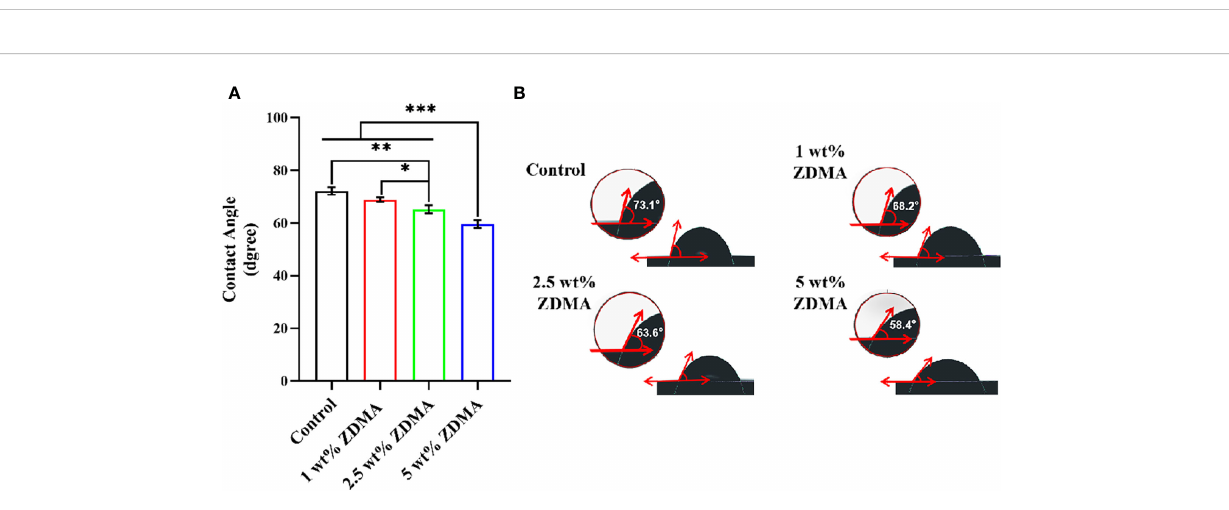
FIGURE 5 The water contact angle measurements of different specimens. (A) Means ± standard deviations for contact angle of each group (*p < 0.05, **p < 0.01, ***p < 0.001). (B) Representative contact angle image of each group.